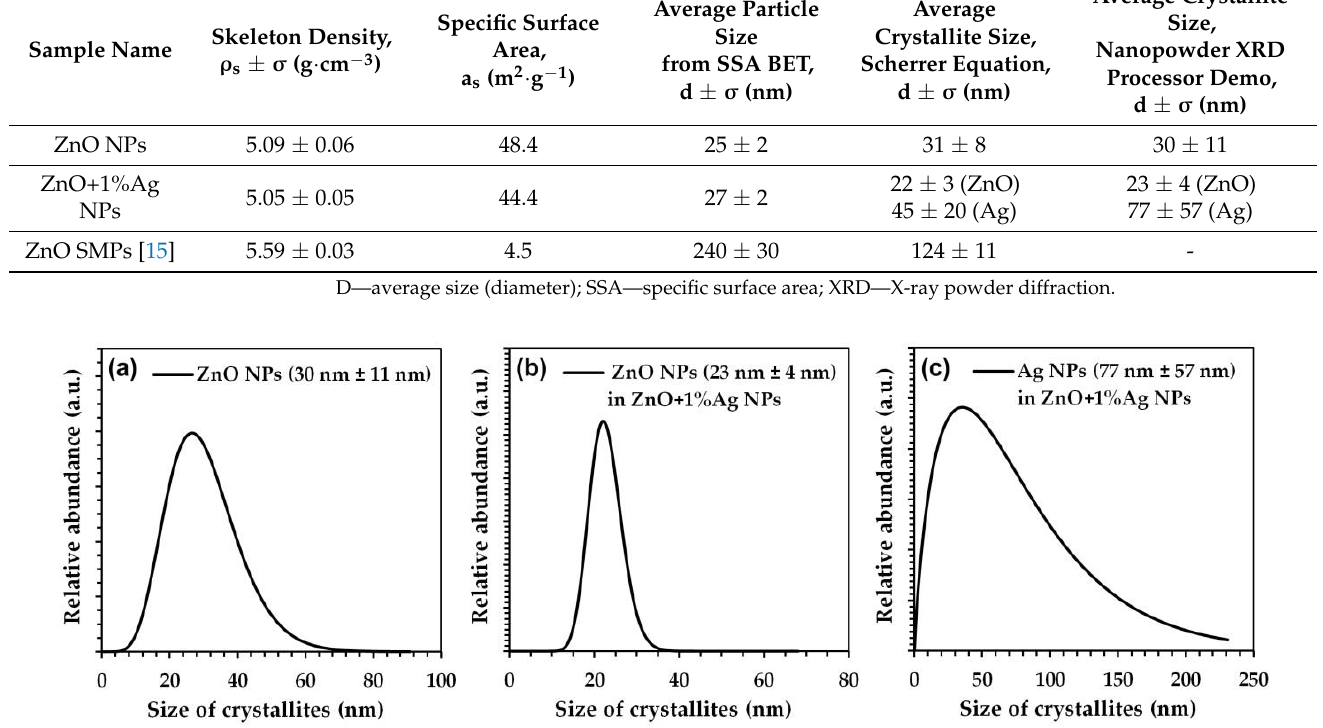
Figure 4. Crystallite size distributions of: ( a ) ZnO NPs, ( b ) ZnO NPs in ZnO+1%Ag NPs, ( c ) Ag NPs in ZnO+1%Ag NPs.